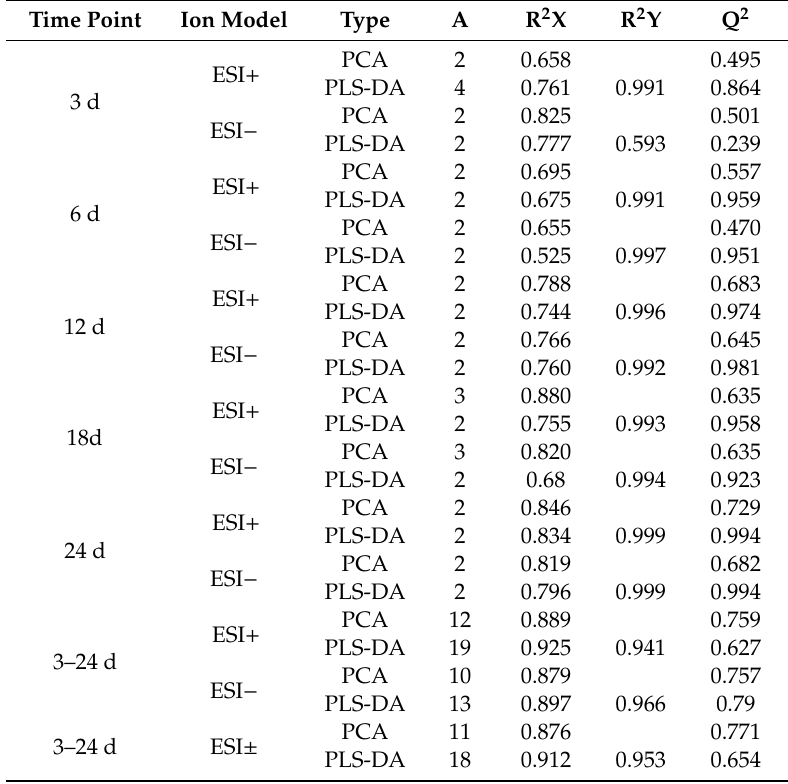
Table 1. Parameters of PCA and partial least squares discriminant analysis (PLS-DA) models by the control and treated models.